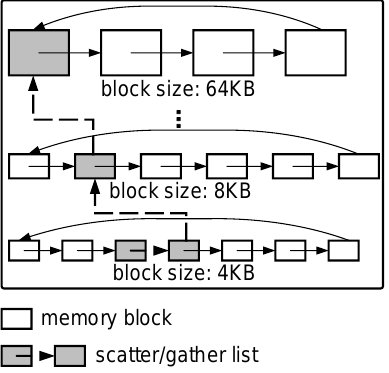
Figure 4. The pinned memory pool